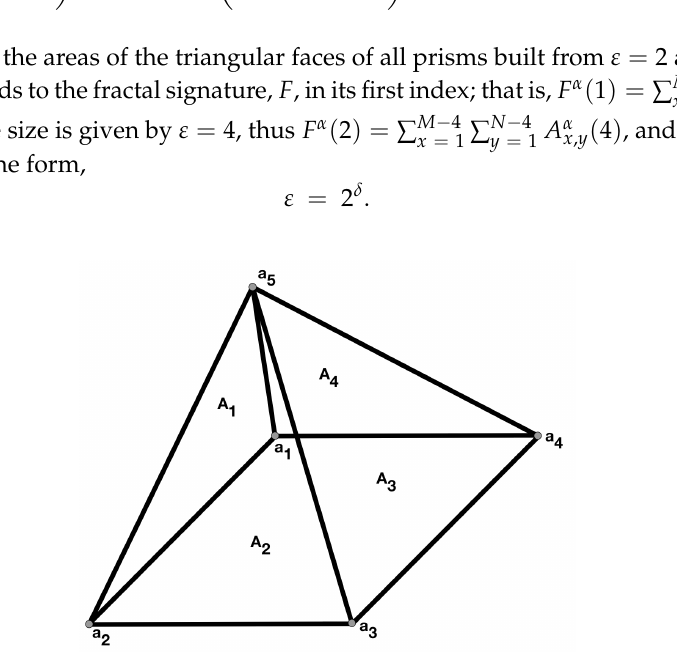
Figure 1. Triangular